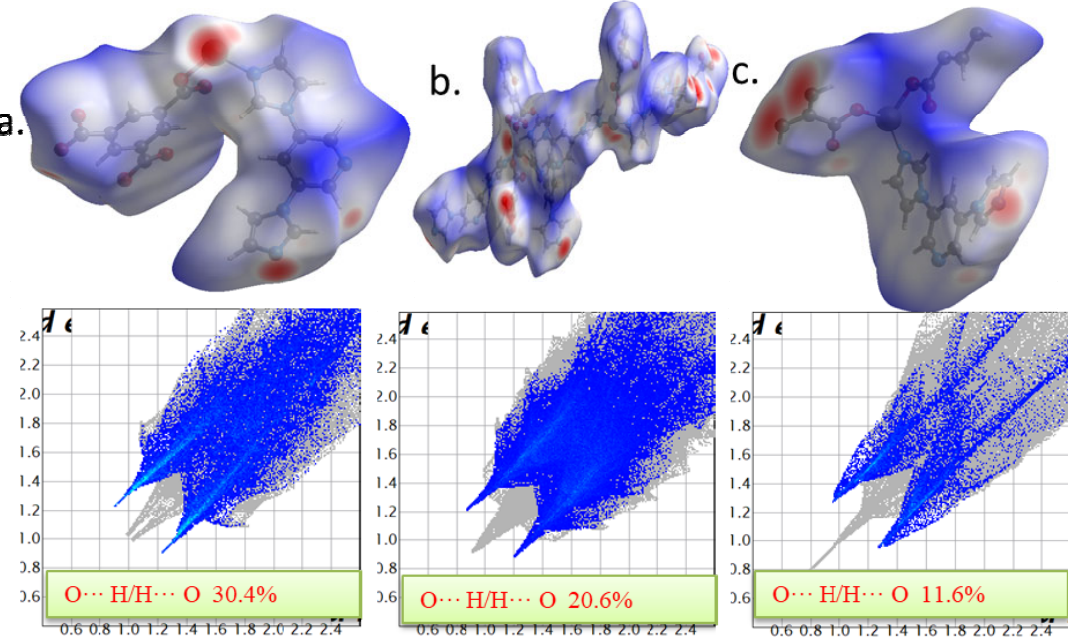
Figure 7. Hirshfeld surface mapped with d norm CPs 1 , 2, and 3 are a , b and c . 2D fingerprint plots of important contacts to HS.